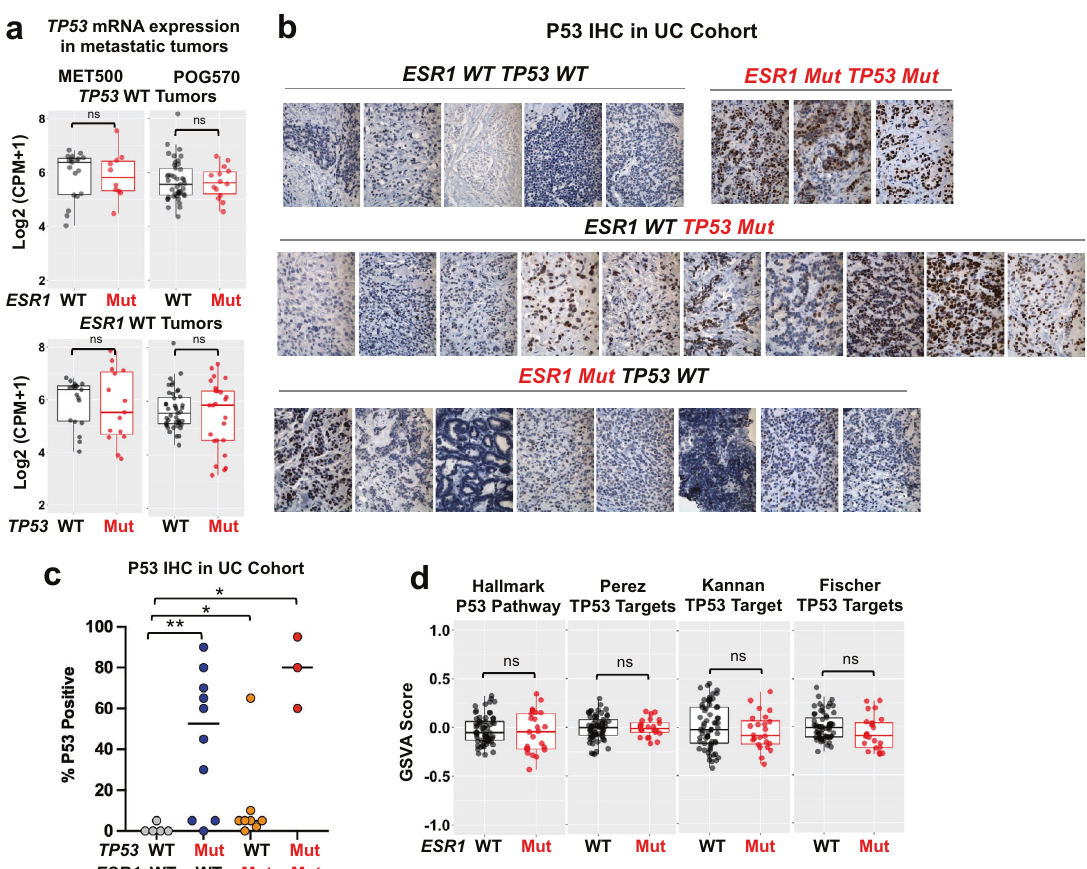
Fig. 2 ESR1 mutations do not affect TP53 expression or TP53 pathway activity in TP53 WT ER + metastatic tumors. a Box plot showing TP53 mRNA expression between ESR1 WT ( n = 19 for MET500; n = 43 for POG570) and mutant ( n = 10 for MET500; n = 14 for POG570) in TP53 WT tumors (upper panel) and TP53 mRNA expression between TP53 WT ( n = 19 for MET500; n = 43 for POG570) and mutant tumor ( n = 15 for MET500; n = 25 for POG570) in ESR1 WT tumors (lower panel) in MET500 and POG570 cohorts. Log2(CPM + 1) values for TP53 gene were extracted from RNA-seq. Box plots span the upper quartile (upper limit), median (center), and lower quartile (lower limit). Whiskers extend a maximum of 1.5× IQR. Mann Whitney U test (two-sided) was applied to each comparison. b Representative images of p53 immunohistochemistry staining of 26 ER + metastatic tumors from UC cohort. Images were classi fi ed by the genotype of ESR1 and TP53 . c Dot plots representing p53 IHC quanti fi cations of B in four different groups. Median of each group was indicated. Mann – Whitney U test (two-sided) was used (* p < 0.05; ** p < 0.01). d Box plots representing the enrichment levels of four different p53-associated gene signatures between TP53 WT; ESR1 WT ( n = 62) and TP53 WT; ESR1 mutant ( n = 24) ER + tumors from merged MET500 and POG570 cohort. Box plots span the upper quartile (upper limit), median (center), and lower quartile (lower limit). Whiskers extend a maximum of 1.5× IQR. Mann – Whitney U test (two-sided) was